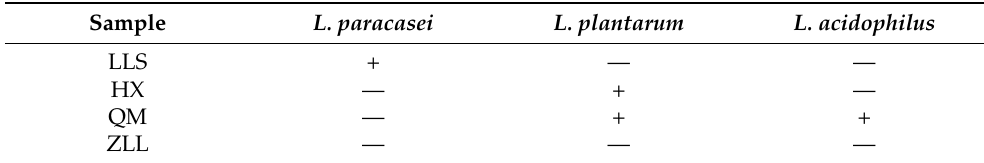
Table 1. Starter cultures compositions of sauerkraut